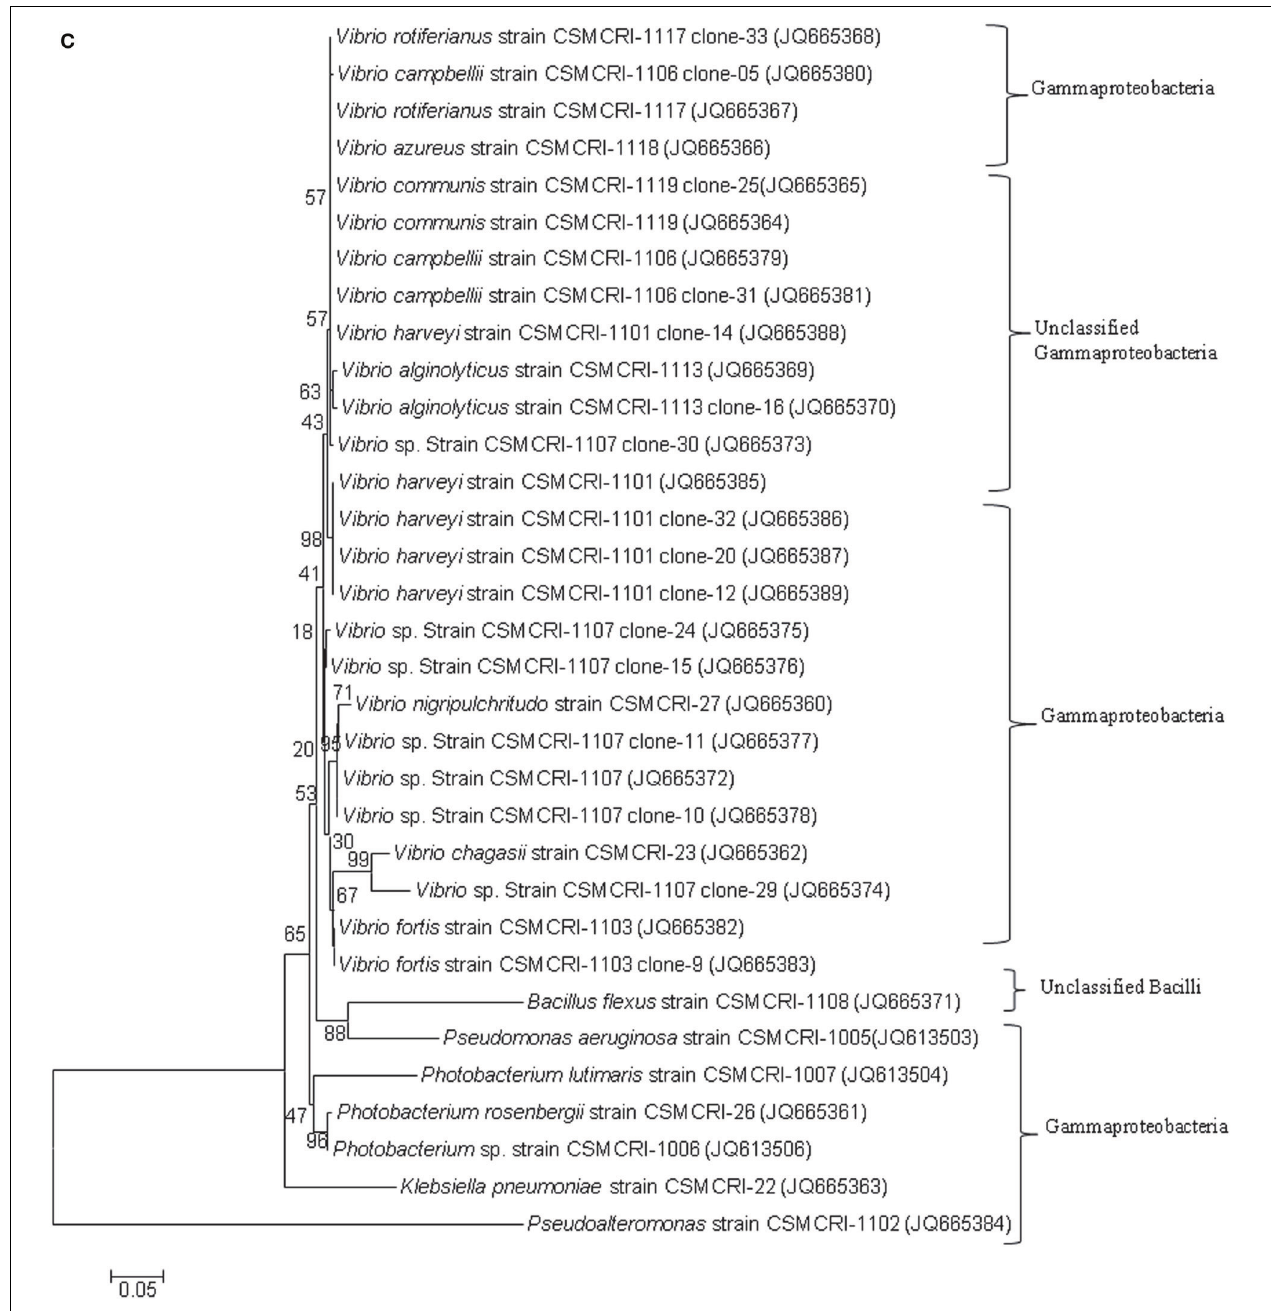
FIGURE 2 | Phylogenetic relationships of bacterial communities isolated from Ulva and Gracilaria species during pre-monsoon (2A), monsoon (2B), and post-monsoon (2C) seasons in 2011. Neighbor-Joining method used for 16S rRNA analysis (Saitou and Nei, 1987). Bootstrap test was performed with 1000 replicates in the phylogenetic trees (Felsenstein, 1985). The tree is drawn to scale, with branch lengths in the same units as those of